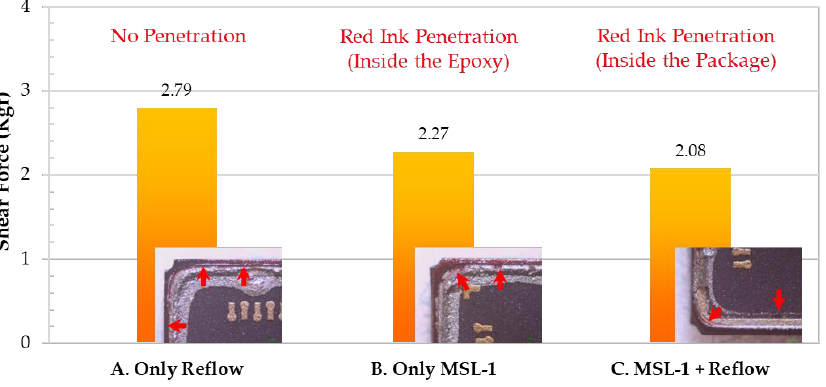
Figure 4. The shear test and red dye penetration test for investigating the root cause.